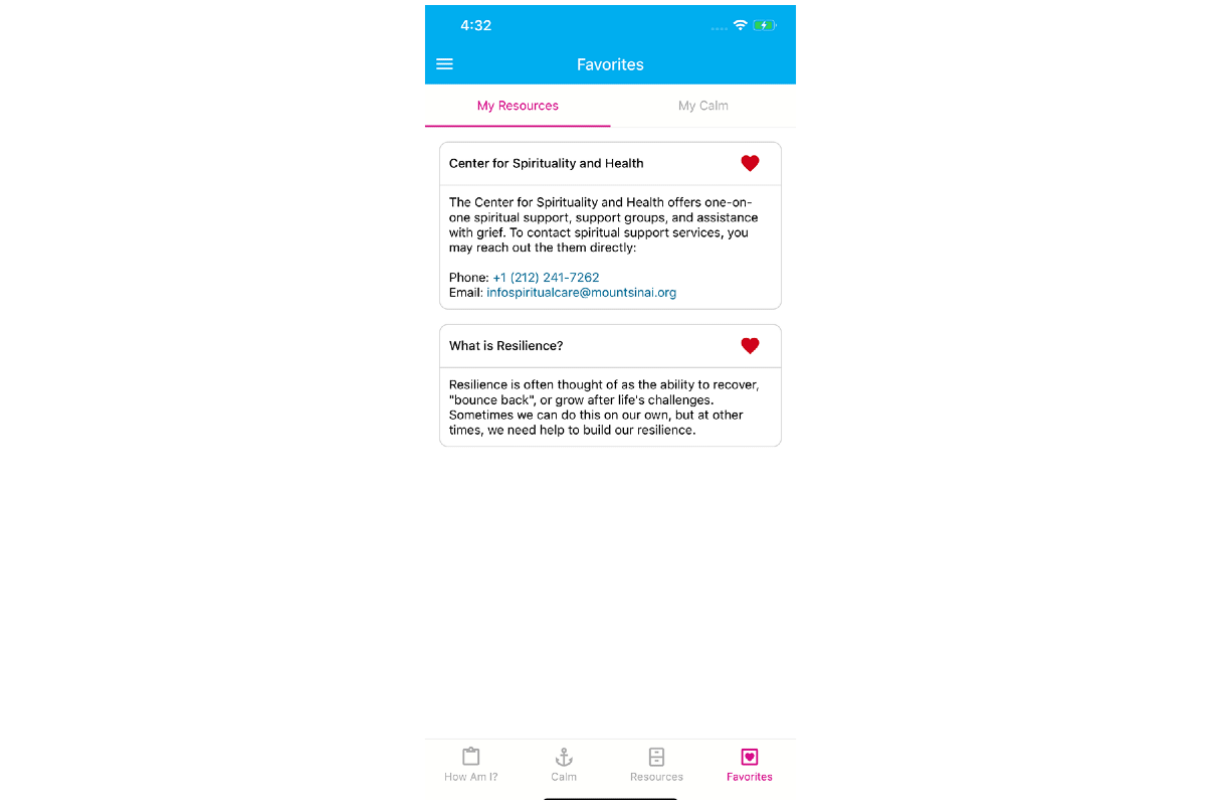
Figure 5. Example of the My Favorites page with resources and contact pages “hearted” and easily accessible.